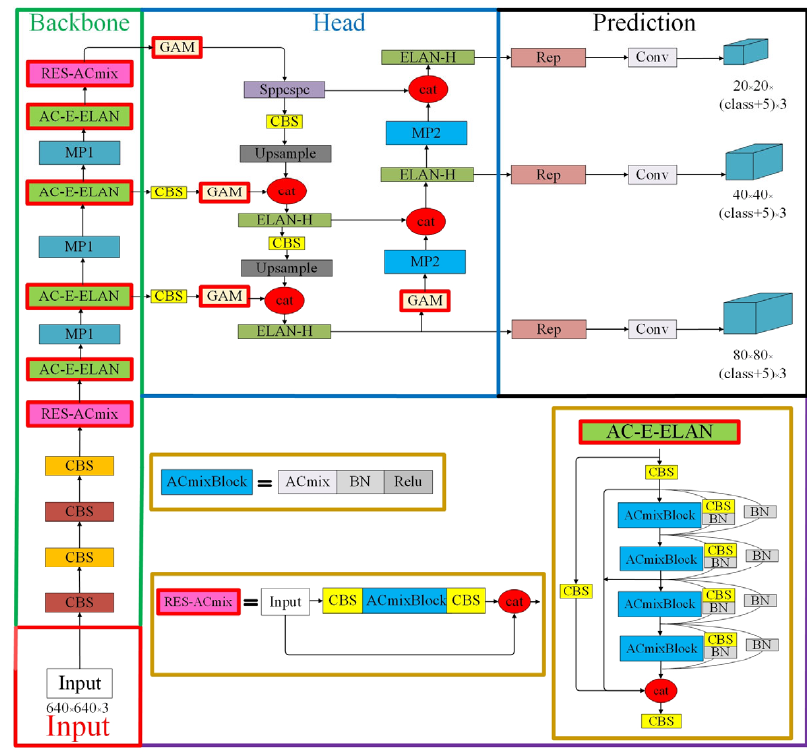
Figure 4. Structure diagram of the YOLOv7-AC model.